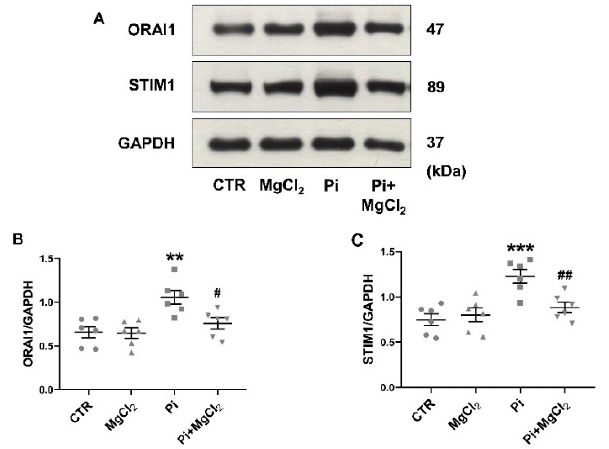
Figure 2. Reversal of ß-glycerophosphate-induced ORAI1 and STIM1 protein expression in megakaryocytes by MgCl 2 . ( A ) Original Western blots of ORAI1, STIM1 and GAPDH protein abundance in megakaryocytes without (CTR) and with prior 24-h exposure to 1.5 mM MgCl 2 alone (MgCl 2 ), 2 mM ß-glycerophosphate alone (Pi) or 2 mM ß-glycerophosphate and 1.5 mM MgCl 2 (Pi+MgCl 2 ). ( B , C ) Arithmetic means ± SEM ( n = 6) of ORAI1 ( B ) and STIM1 ( C ) protein abundance in megakaryocytes without (CTR) and with prior 24-h exposure to 1.5 mM MgCl 2 alone (MgCl 2 ), 2 mM ß-glycerophosphate alone (Pi) or 2 mM ß-glycerophosphate and 1.5 mM MgCl 2 (Pi+MgCl 2 ). ** ( p < 0.01), *** ( p < 0.001) indicate statistically significant differences compared to CTR; # ( p < 0.05), ## ( p < 0.01) indicate statistically significant differences compared to Pi alone (ANOVA). CTR, control.